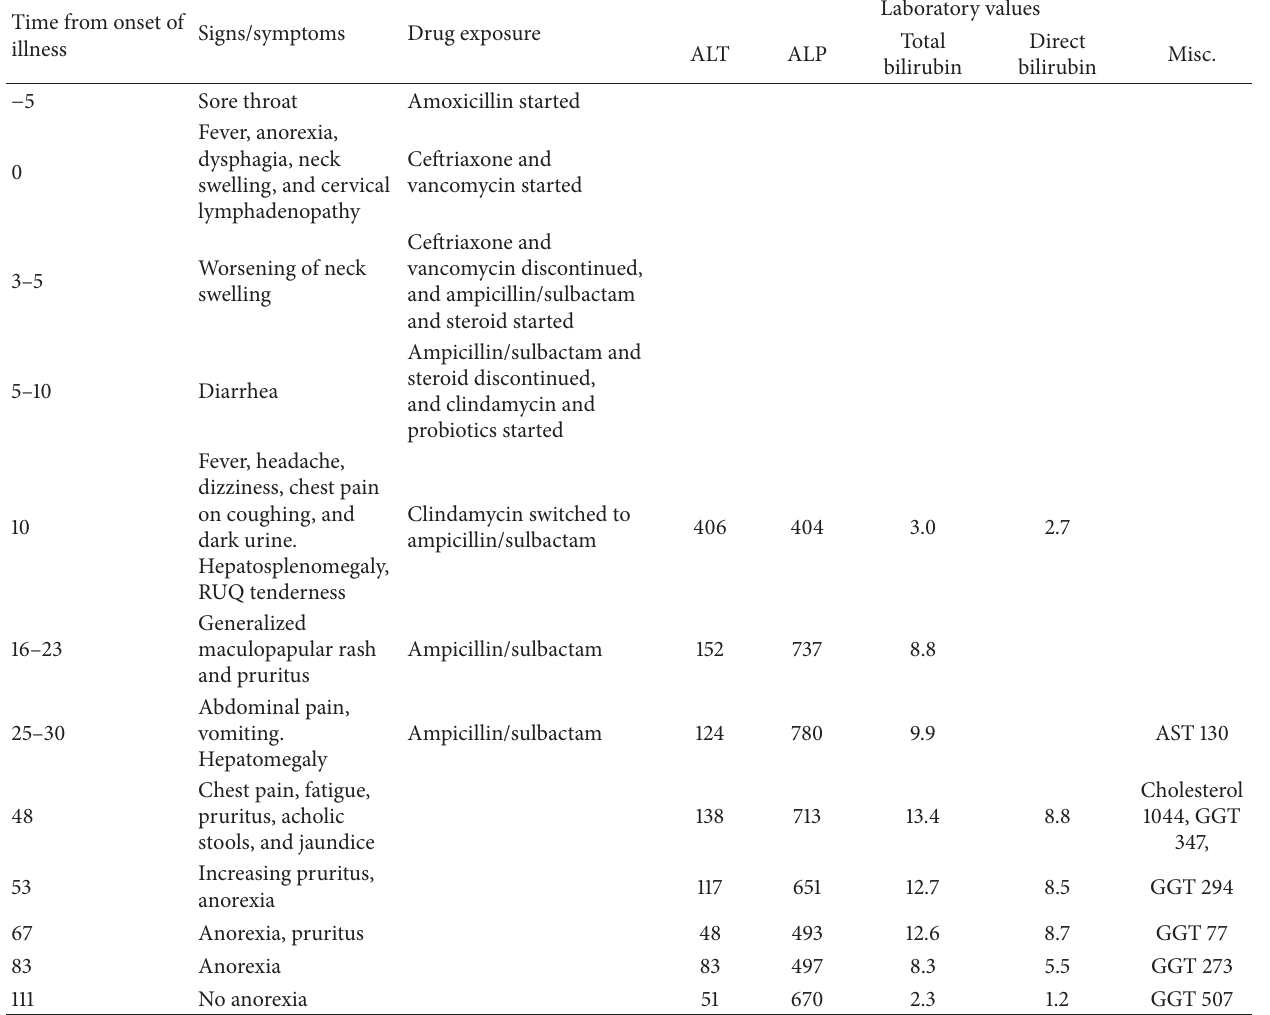
Table 1: Correlation between clinical and biochemical manifestations and drug administration. Time from onset